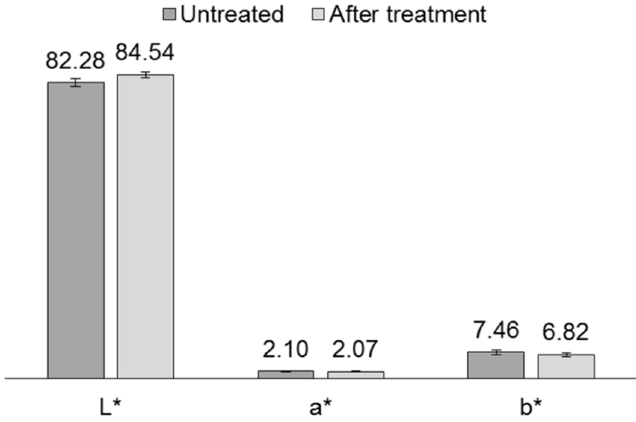
Figure 3. Average chromatic values according to CIELAB system before and after TiO 2